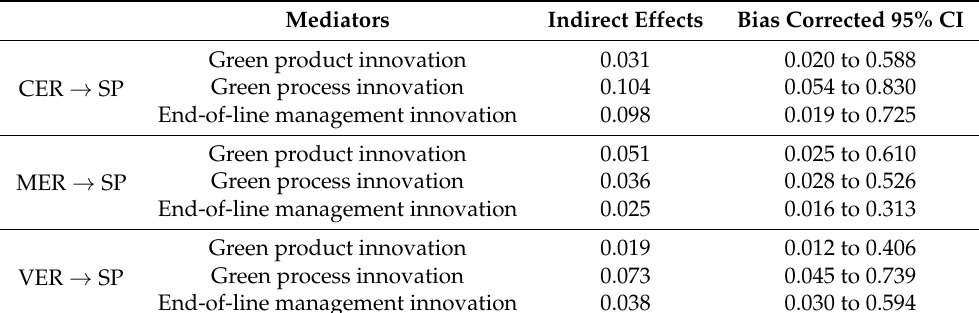
Table 6. Indirect effects of environmental regulations on sustainability performance through green technology